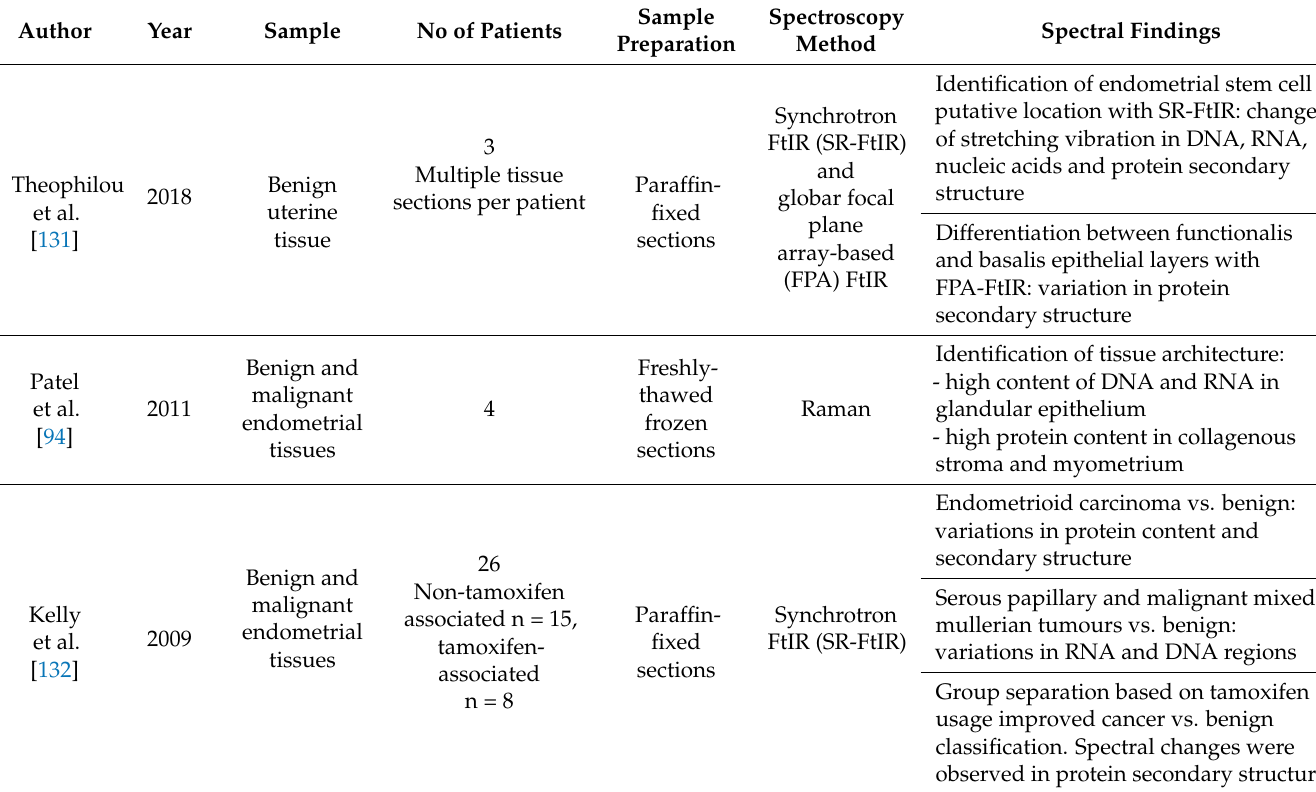
Table 1. Spectroscopy of uterine tissues/cells, studies included in this